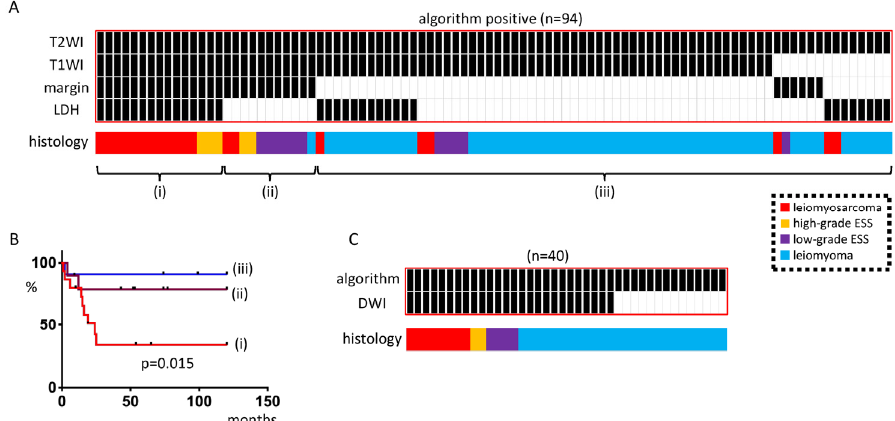
Figure 2. Analysis of algorithm-positive cases. ( A ) Algorithm-positive cases in the Kyoto cohort, Kindai Cohort I, and Kindai Cohort II ( n = 94). The cases were divided into three groups: Group (i): all four factors of the algorithm were positive; Group (ii): three factors of the image were positive; Group iii: others. For Group (ii), all but one were sarcomas; for Group (iii), most were myomas, but some were sarcomas. ( B ) Prognosis differed among the three groups, with Group (i) having the poorest prognosis. ( C ) Forty of the algorithm-positive cases had available DWI and DWI was high for all sarcomas. The heatmap shows cases with a high DWI (shown in black).